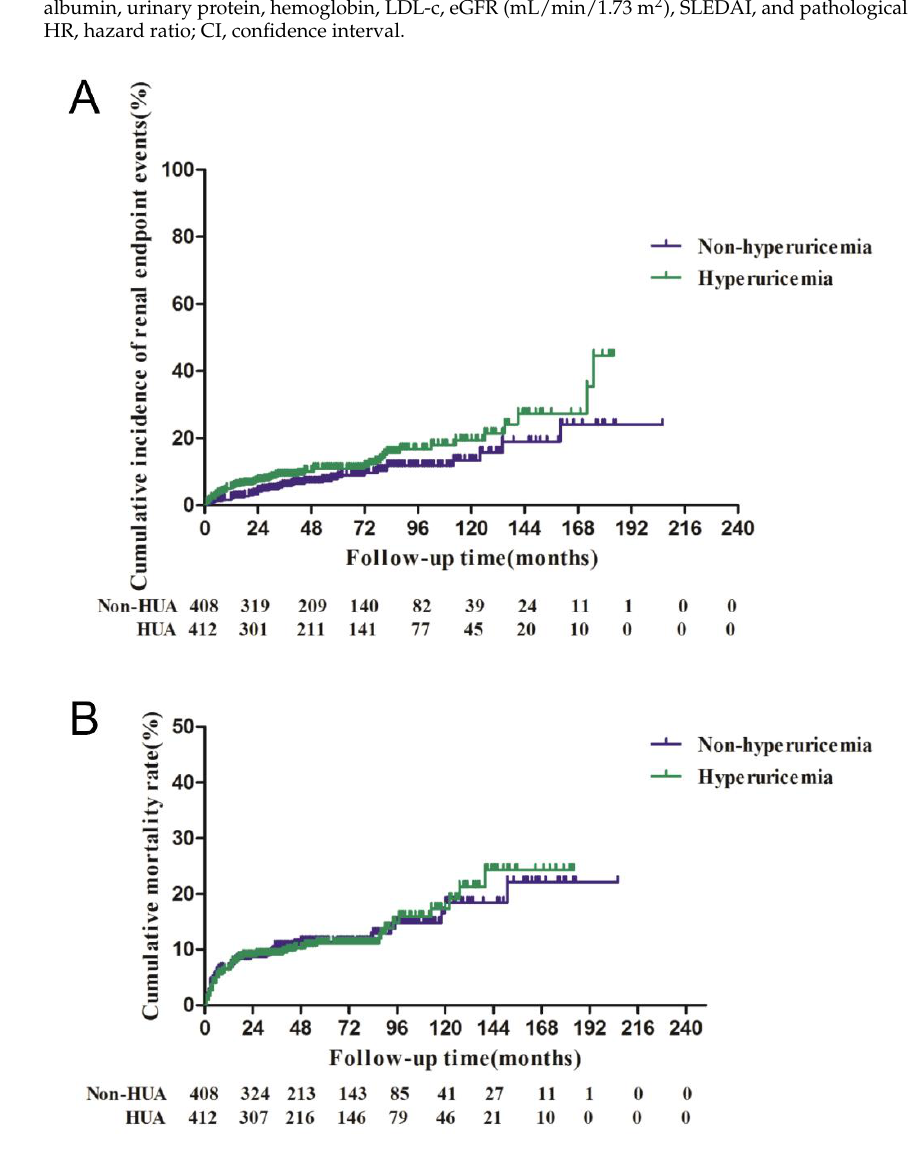
Table 3. Hyperuricemia as a risk factor for clinical outcomes, as assessed by Cox regression models. Unadjusted